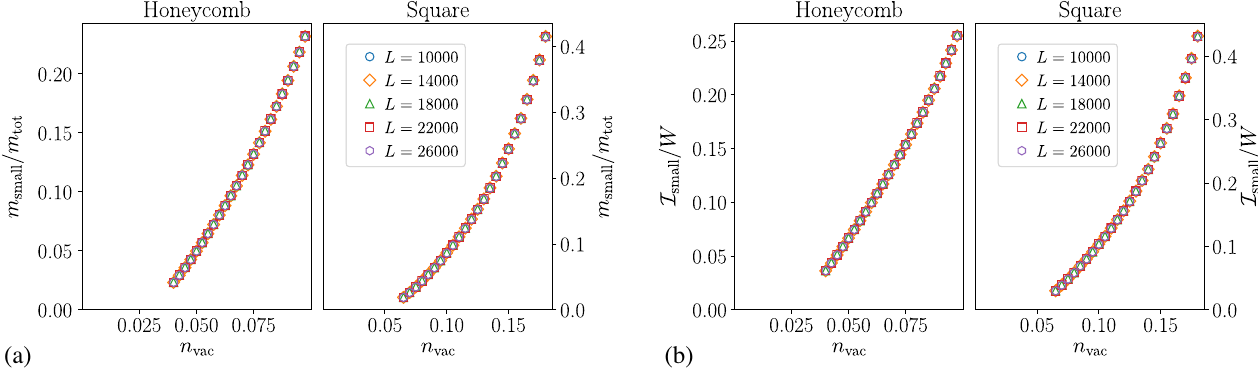
=m , where m is the contribution of “ small ” R -type regions (with less than 10 000 small tot small . In panel (b), the same holds true for the corresponding ratio vac